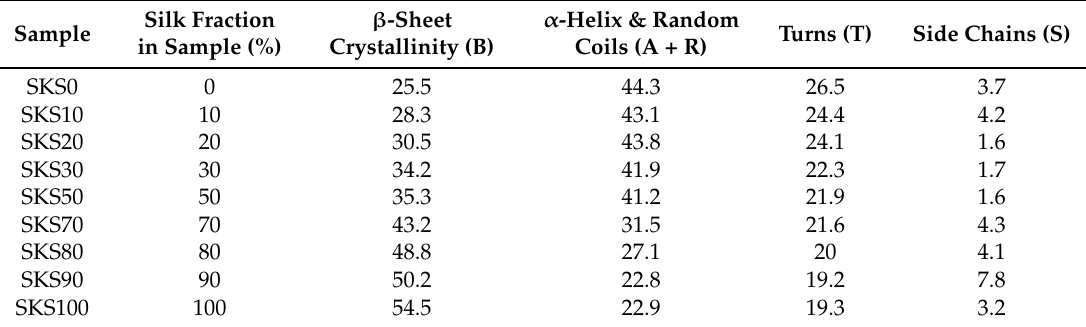
Table 1. Percentage of secondary structures in ultrasonicated silk fibroin/keratin blends (all